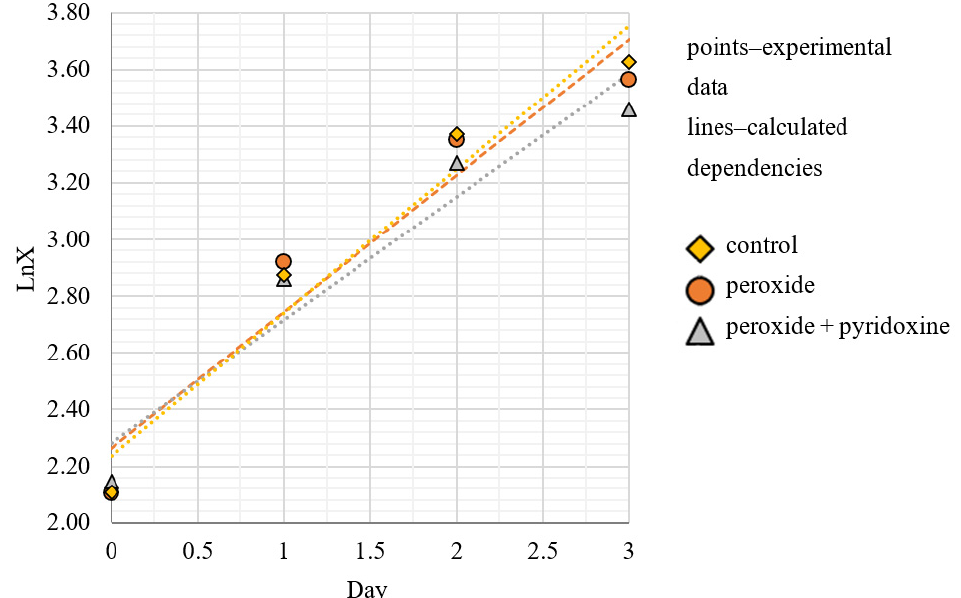
Figure 2. Exponential growth phase of the C. vulgaris BIN microalgae population in semi-logarithmic coordinates.